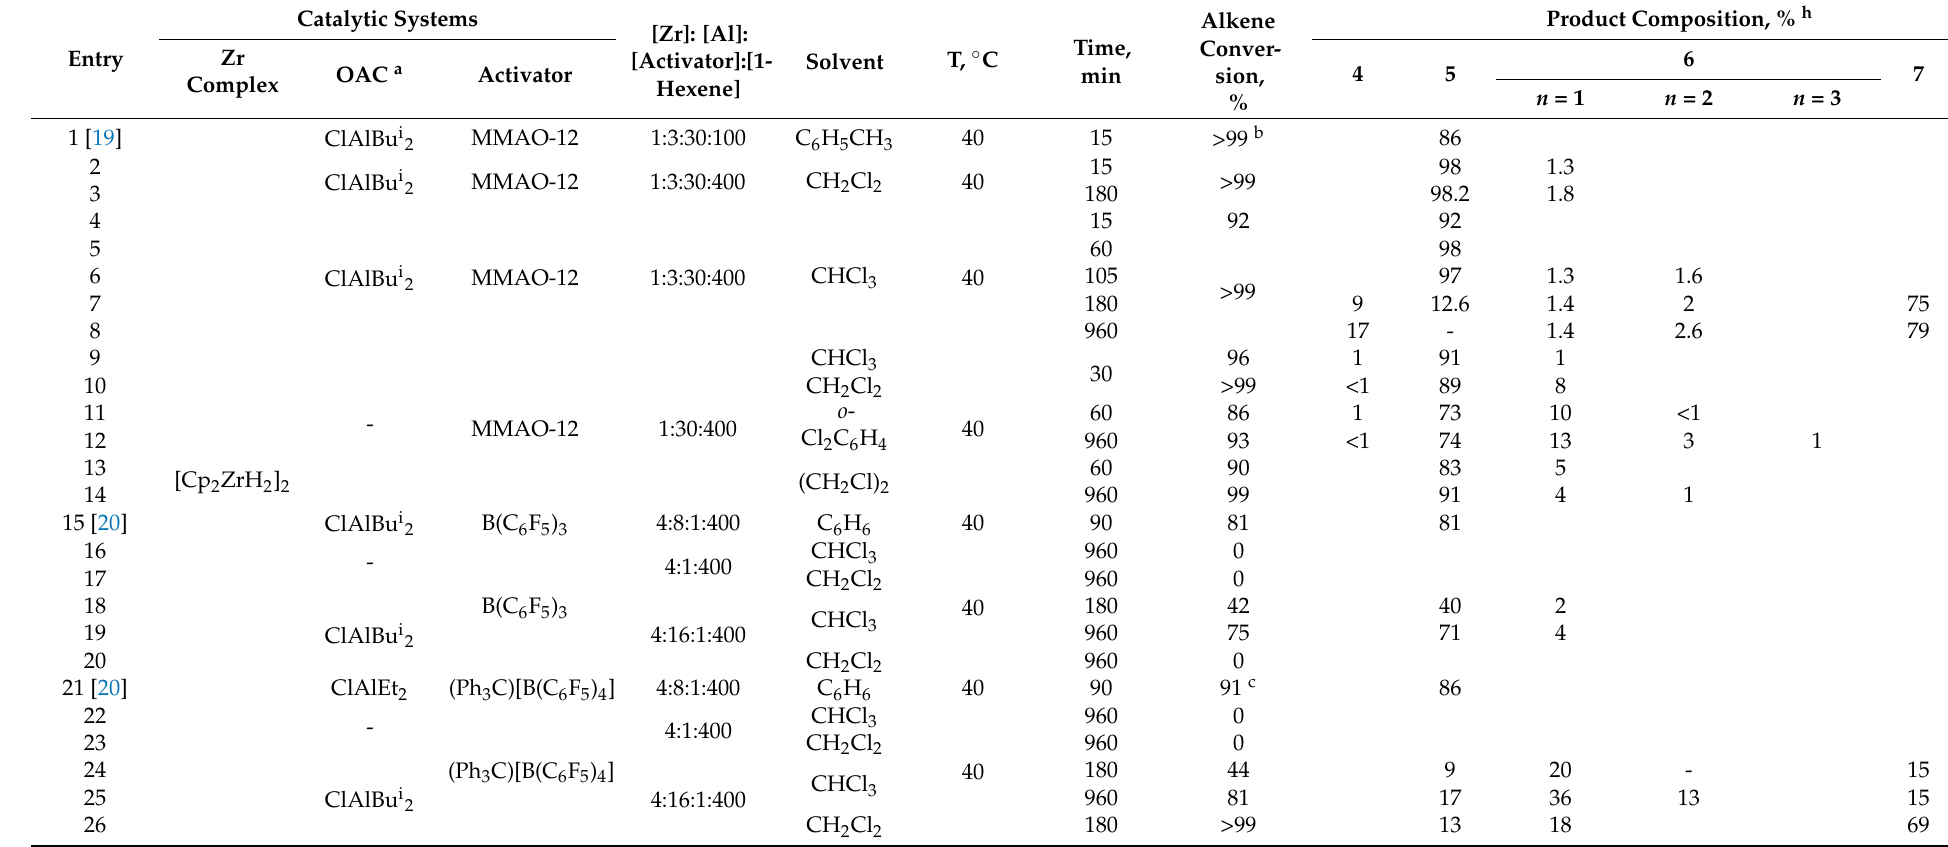
Table 1. Catalytic activity and chemoselectivity of systems A and B in the reaction with